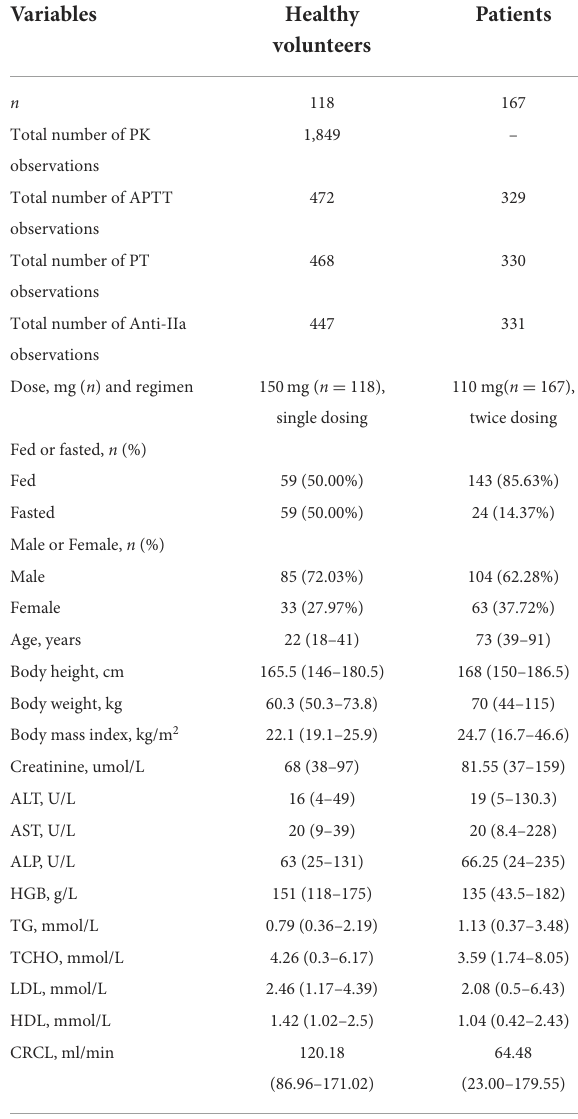
TABLE 1 Baseline characteristics of subjects included in the